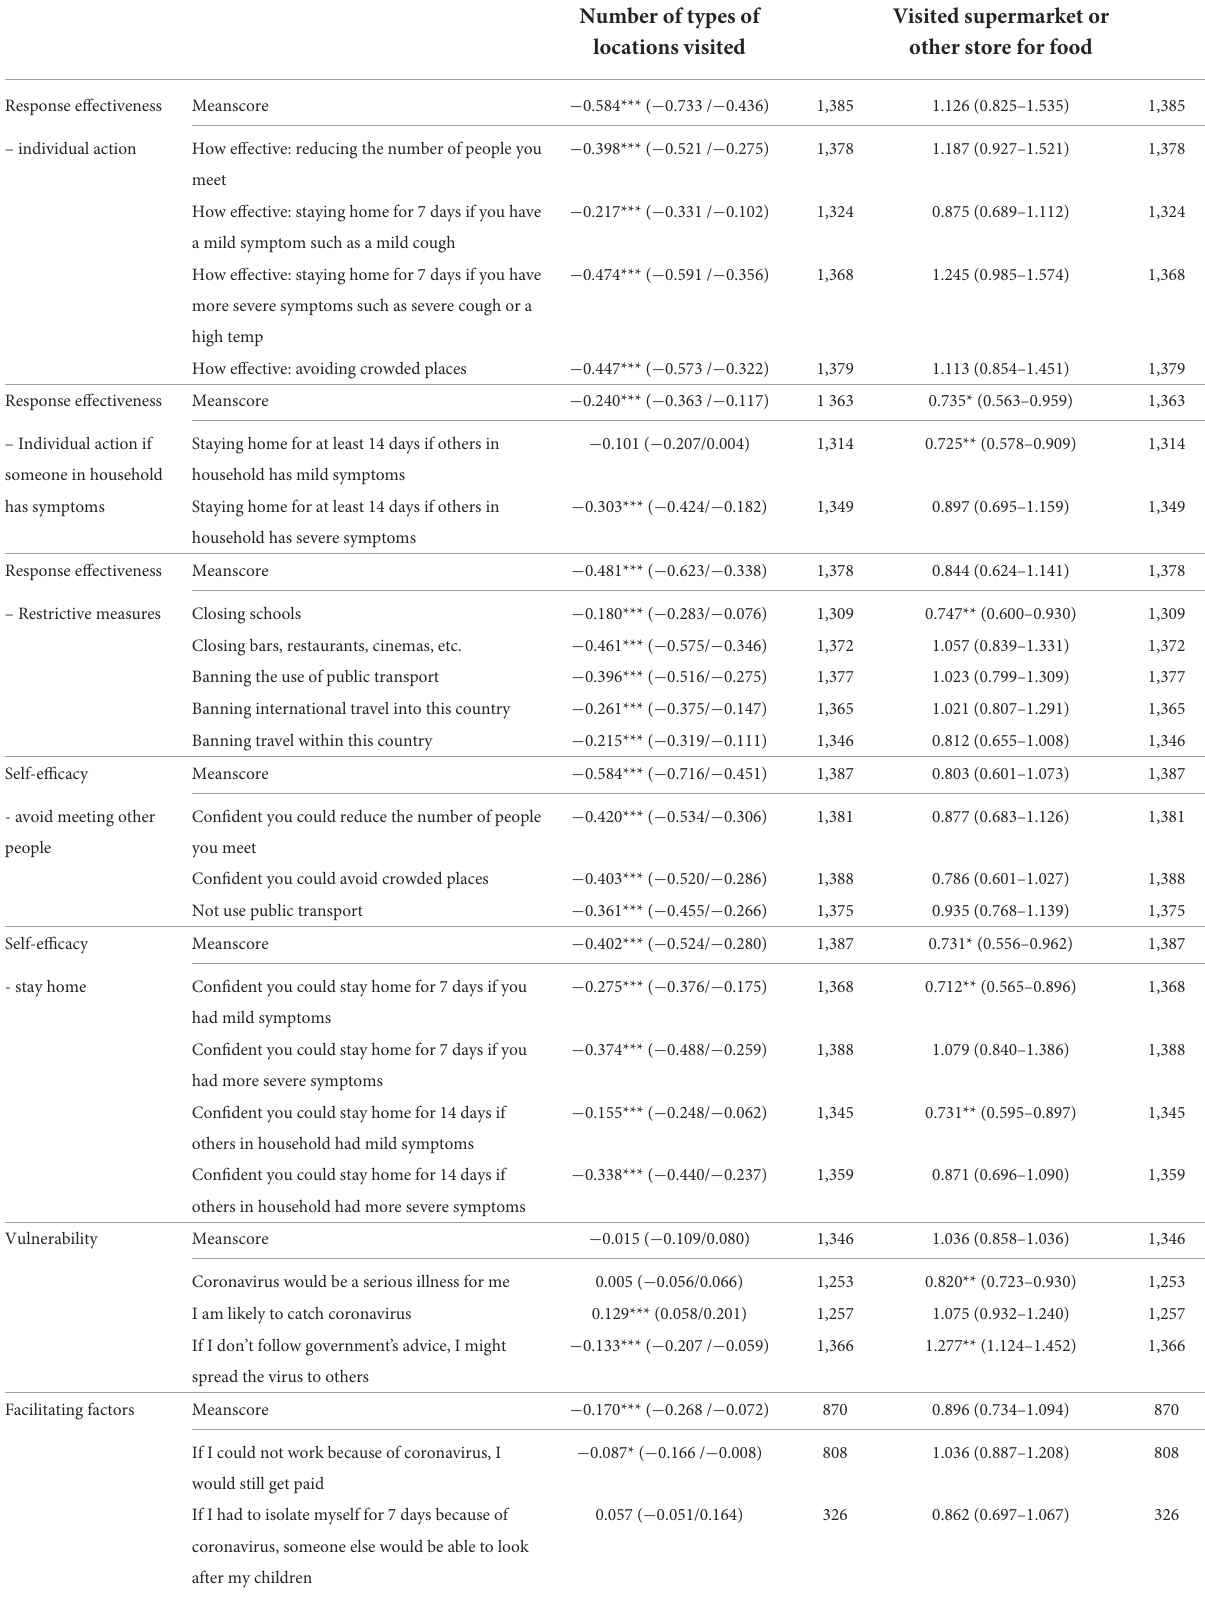
TABLE 4 Behavioral outcomes by cognitive predictors and facilitating factors/barriers. Bivariate